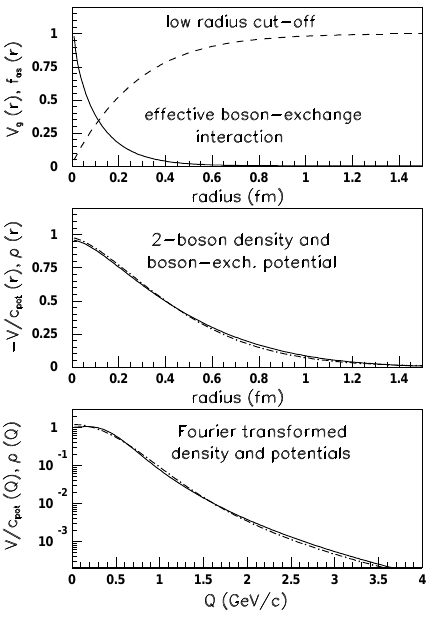
Fig. 1. Solution for a scalar state with a mass of 0.55 GeV. Upper part: low radius cut-o ff function f as ( r ) and interaction ∼ f ( r ) / r given by dashed and solid line, respectively. In the lower two parts the two-boson overlap density and the corresponding po- tential are given by the overlapping dot-dashed and solid lines in r- and Q-space, which are matched by a boundary condition.